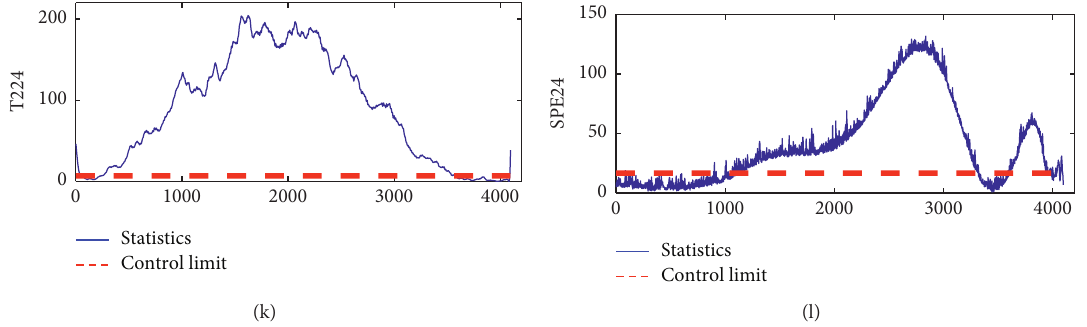
Figure 9: Case Western Reserve University bearing outer ring failure results based on Deep EMD-PCA.